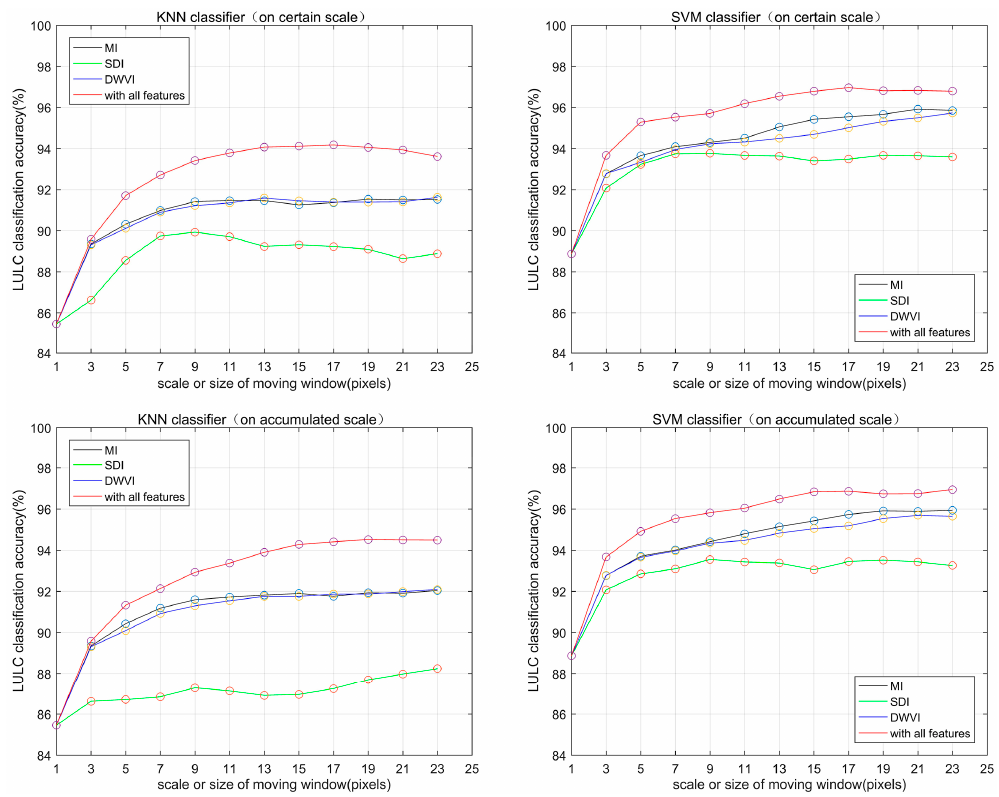
Figure 4. Overall accuracies of the land use and land cover (LULC) classifications with different feature set configurations.